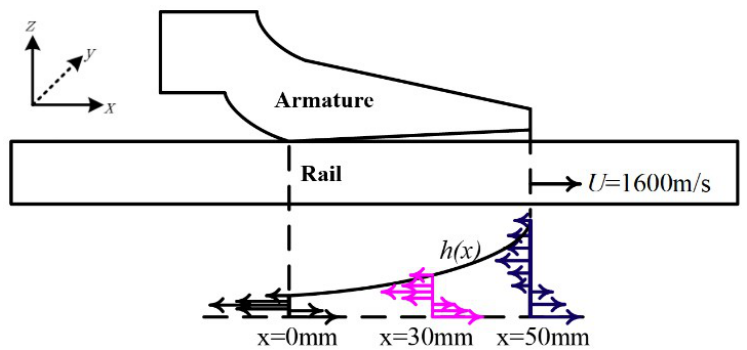
Figure 10. Velocity distribution schematic diagram of metal liquid film at different positions of the contact surface at U = 1600 m/s.